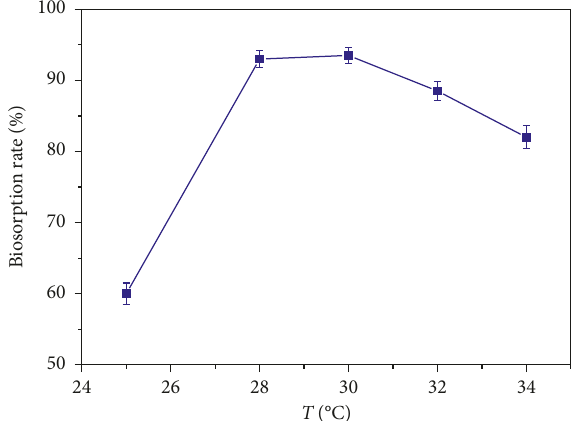
Figure 3: Effect of temperature on biological modification.